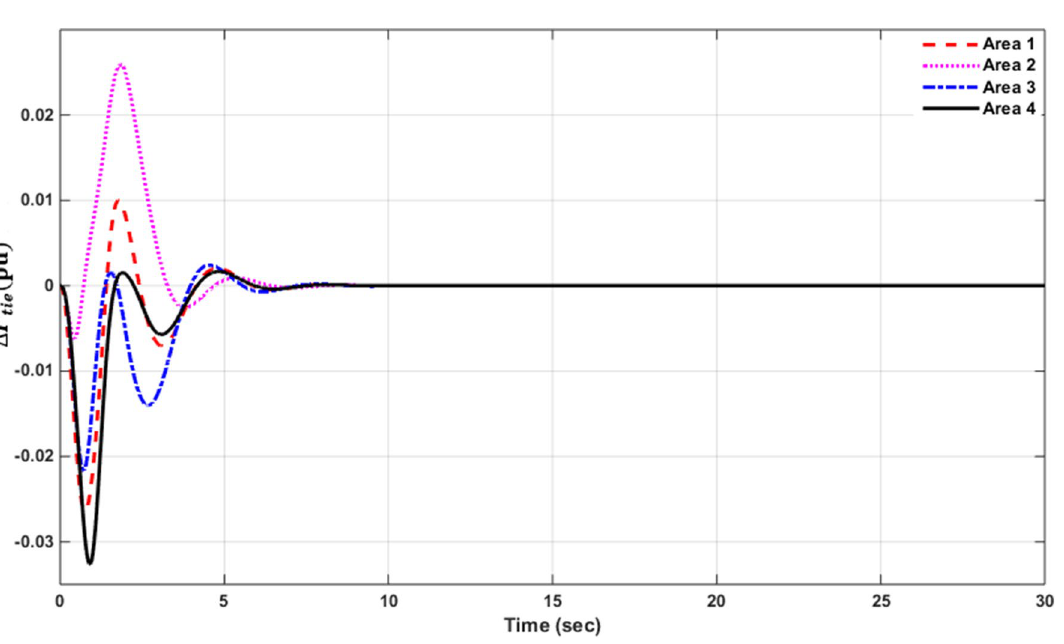
Figure 6. Tie-line power deviations in four areas when no disturbance is imposed.